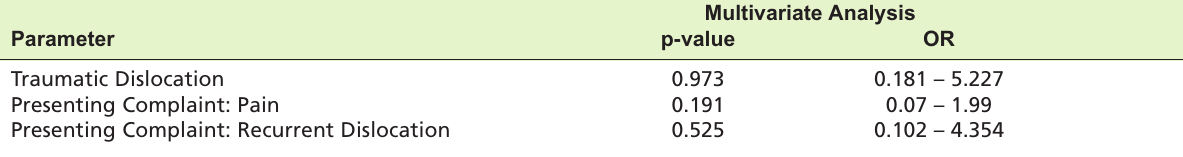
Multinomial logistics regression analysis to identify risk factors for shoulder instability in patients with Table II: the painful apprehension test Multivariate